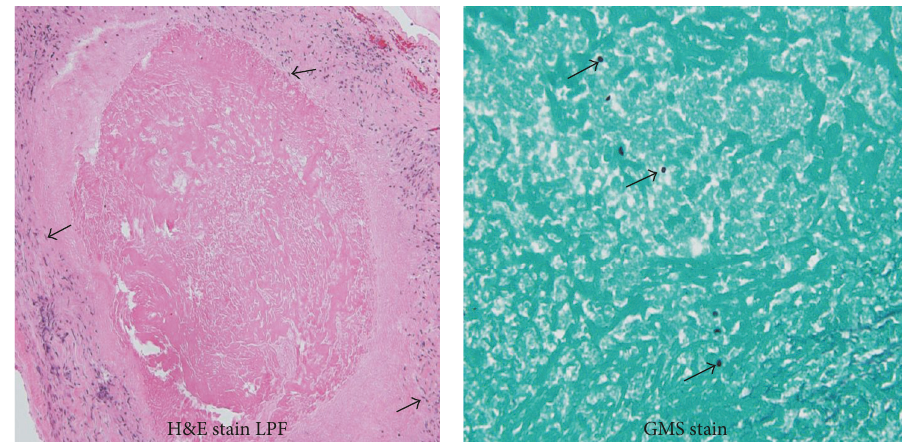
Figure 2: Histologic images. H&E stain of the atrial appendage showing epithelioid histiocytes (arrows), lymphocytes, and caseating granuloma (high power view of hematoxylin-eosin stain). Fungal elements (arrows) within central necrosis (Grocott methenamine silver stain, 400x